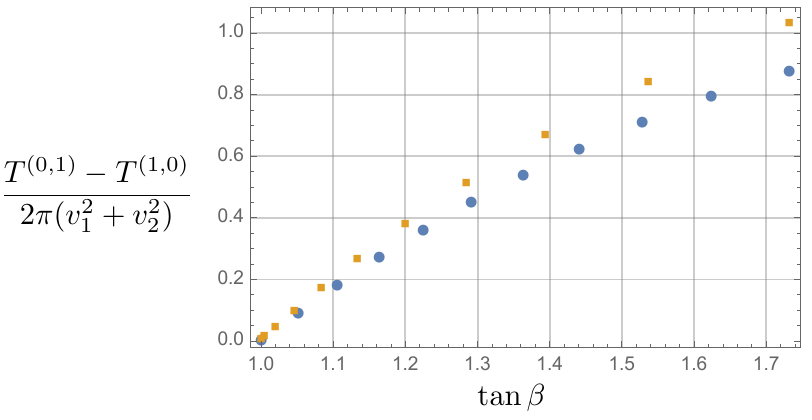
Figure 10 . Di(cid:11)erence of the tensions of (0 ; 1)-string and (1 ; 0)-strings normalized by 2 (cid:25) ( v 2 For numerical computation, we set the parameters g = g 0 = (cid:21) 1 = (cid:21) 2 = (cid:21) 4 = 1. For square symbols, (cid:21) 3 is taken to be 0 and (cid:22) is varied, while for circles, (cid:22) is taken to be 0 and (cid:21) 3 is varied. The horizontal axis represents the value of tan (cid:12) for given input